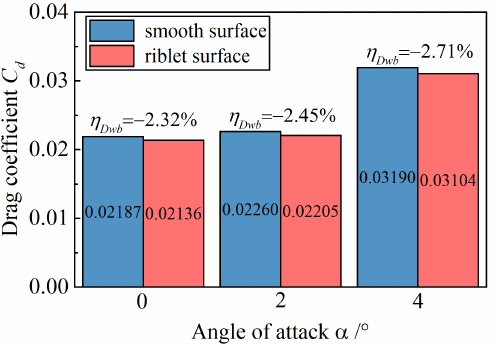
Figure 17. Numerical results of the modified SST-RC model.